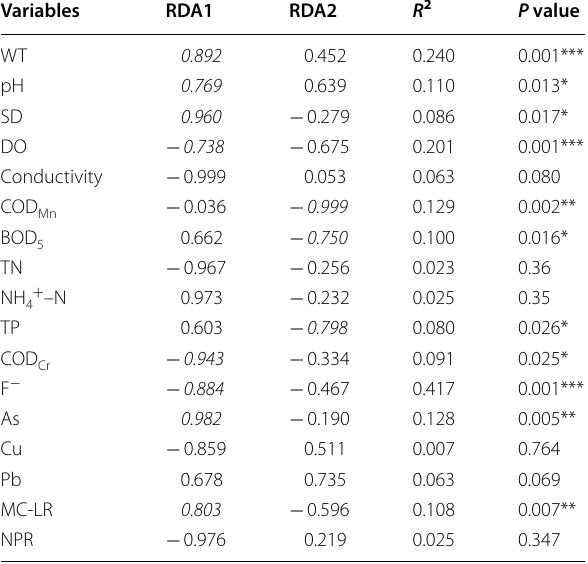
Correlations with RDA1 and RDA2, R 2 and p values are shown. Significance was expressed as * p < 0.05, ** p < 0.01, and *** p < 0.001